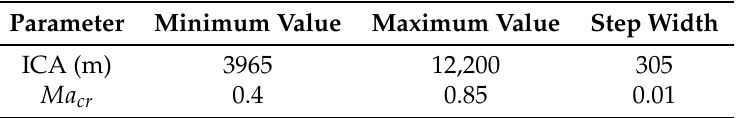
Table 2. Range of parameter variations (initial cruise altitude (ICA), Mach number at cruise flight ( Ma cr )) applied in the present study to derive the operational mitigation